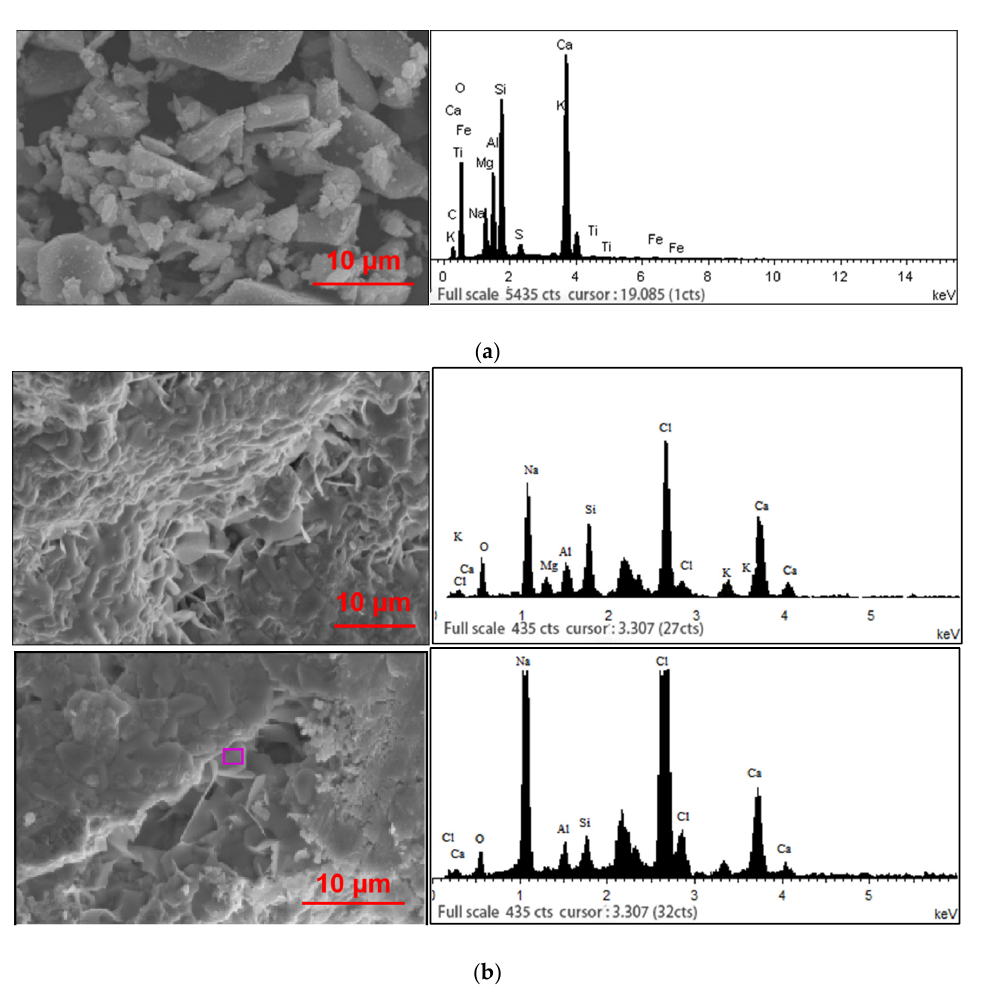
Figure 3. SEM-EDS spectrum of fly ash gels and mineral slag. ( a ) SEM-EDS spectrum of mineral slag. ( b ) SEM-EDS spectrum of fly ash in grate furnace incineration.